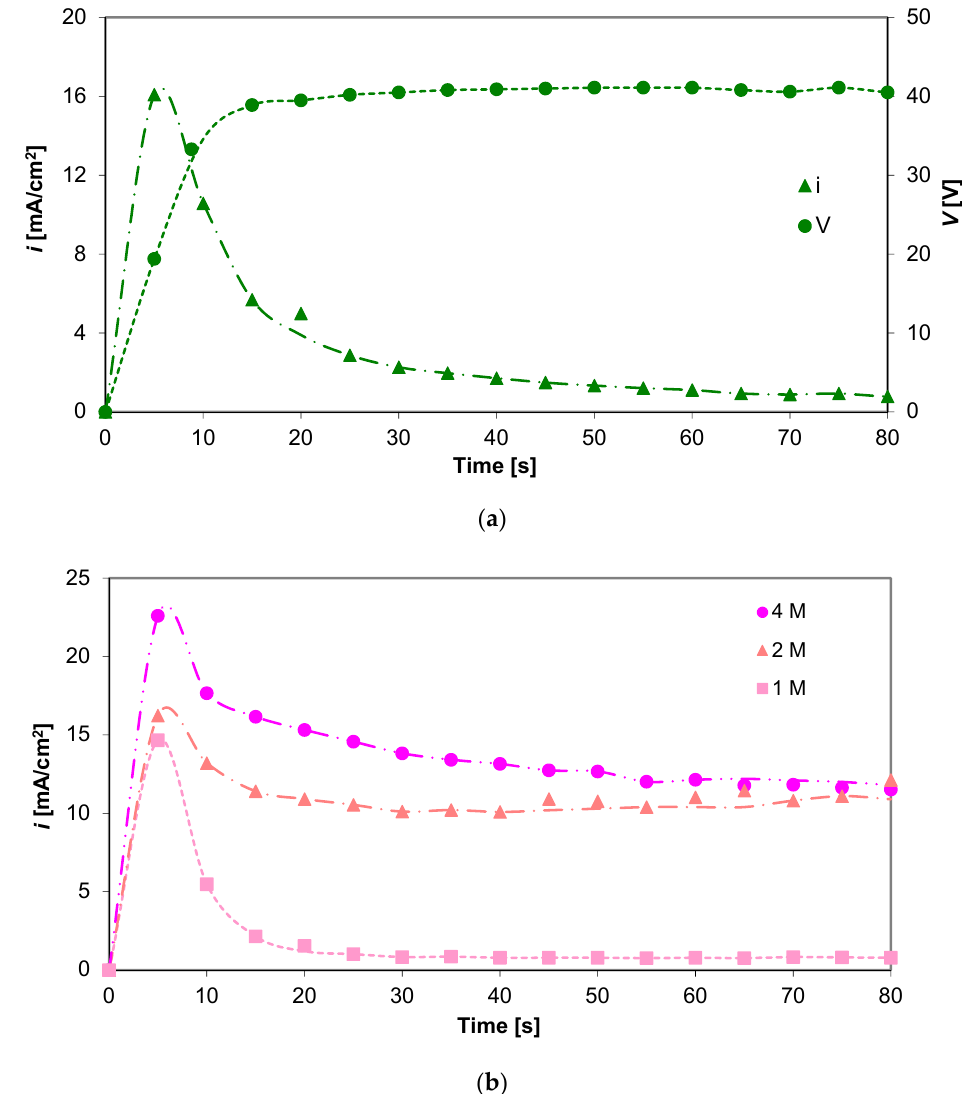
Figure 1. ( a ) Evolution of current density and voltage during the anodic oxidation of Ti ‐ 6Al ‐ 4V at 40 V; ( b ) Evolution of current density during the anodic oxidation performed with different sulfuric acid concentration (1 M, 2 M, and 4 M) at 60 V.